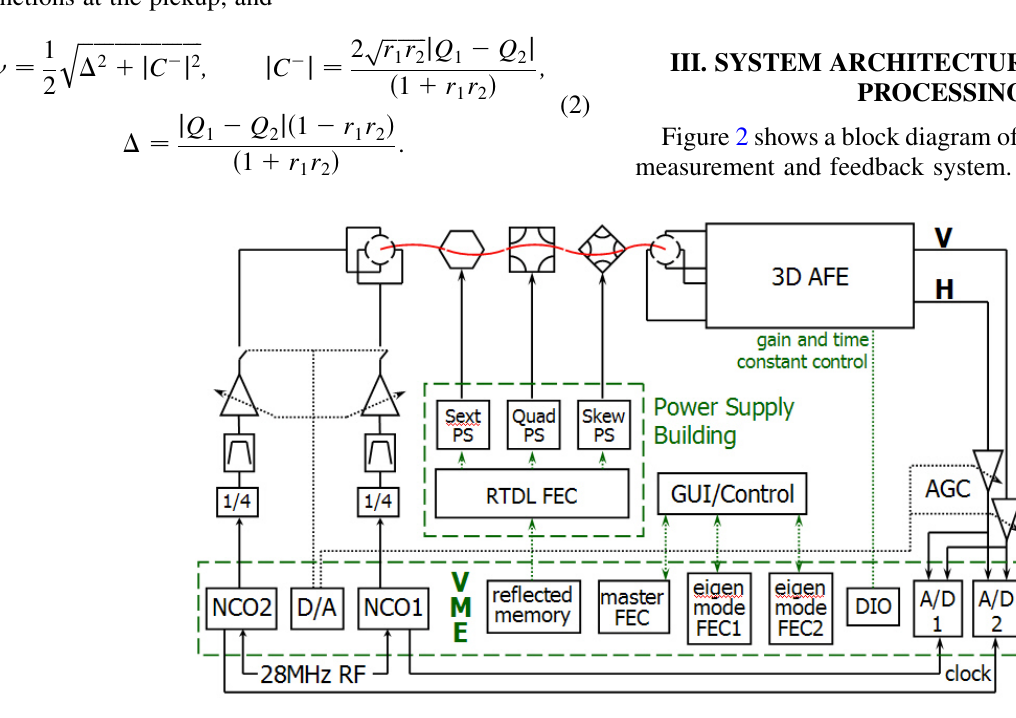
FIG. 2. (Color) System block diagram.